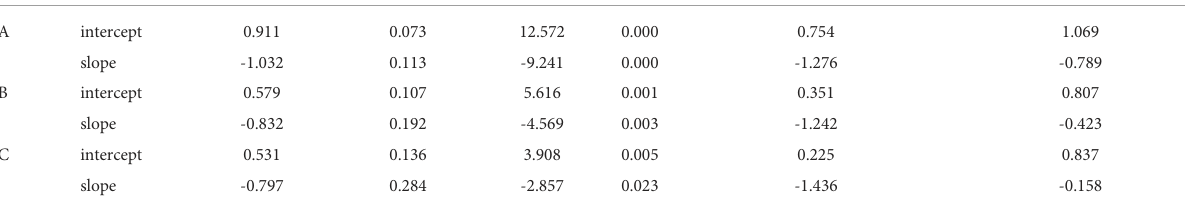
TABLE 2 Regression models of epitope-speci fi c repertoires: the average values of slopes and intercepts across three peptides for each donor are